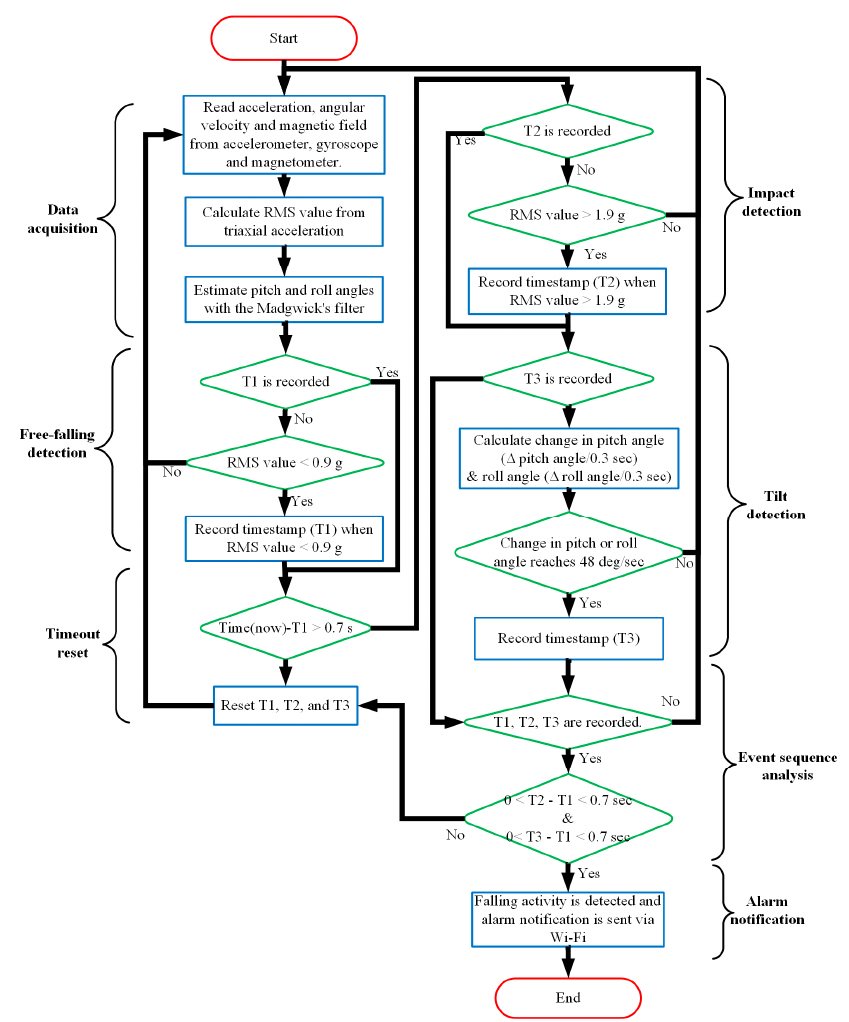
Figure 3. Flowchart of proposed scheme for threshold-based fall detection.